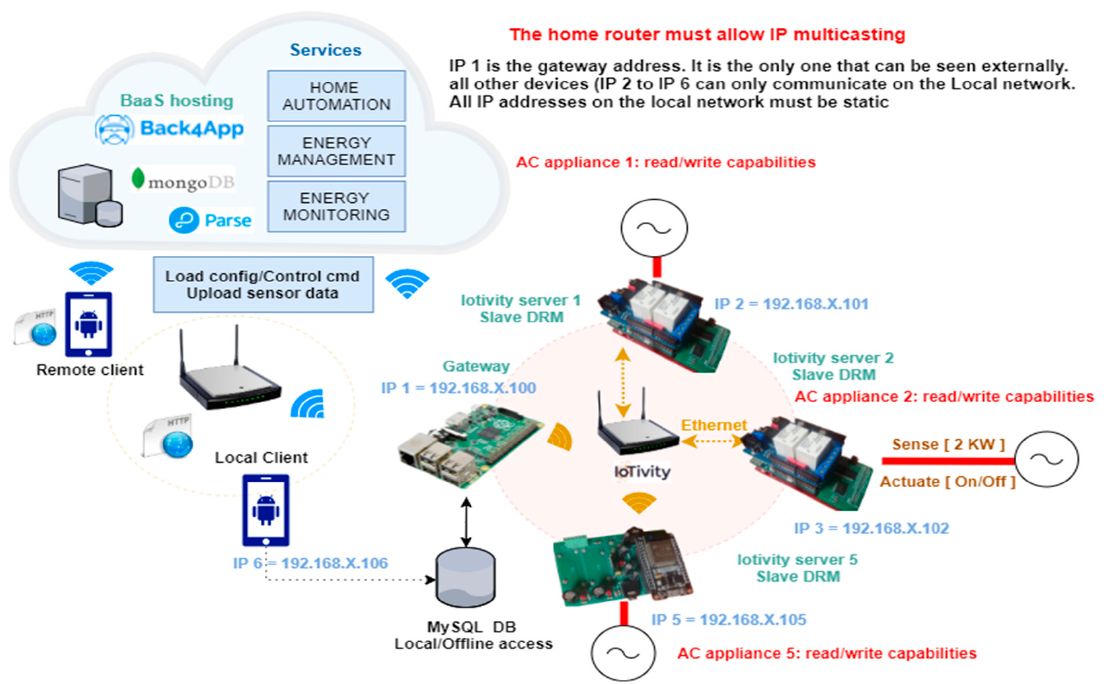
IoT 2022 , 2 , Figure 13. Case study system architecture . Figure 13. Case study system architecture.